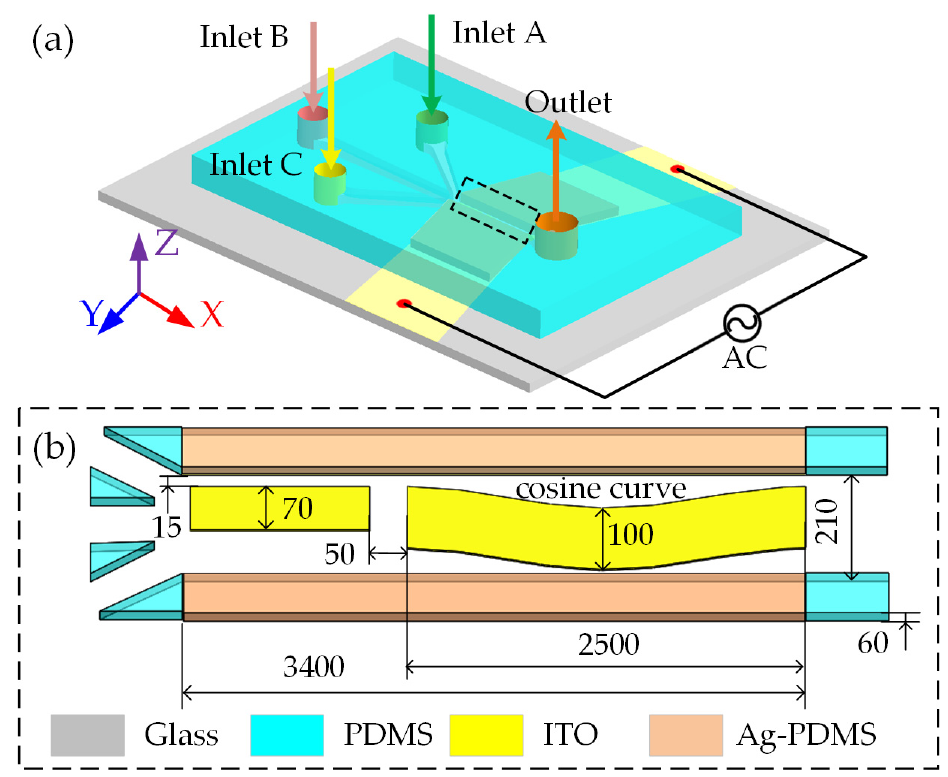
Figure 1. Schematic illustration of the electrokinetic micromixer: ( a ) three-dimensional model of the micromixer; ( b ) specific dimension (in units of microns) of the micromixer. Outside the double layer, the field lines are expelled and induce two fluidic rolls on the electrode surface. The induced-charge electroosmotic slip is governed by Helmholtz– Smoluchowski formula [34]